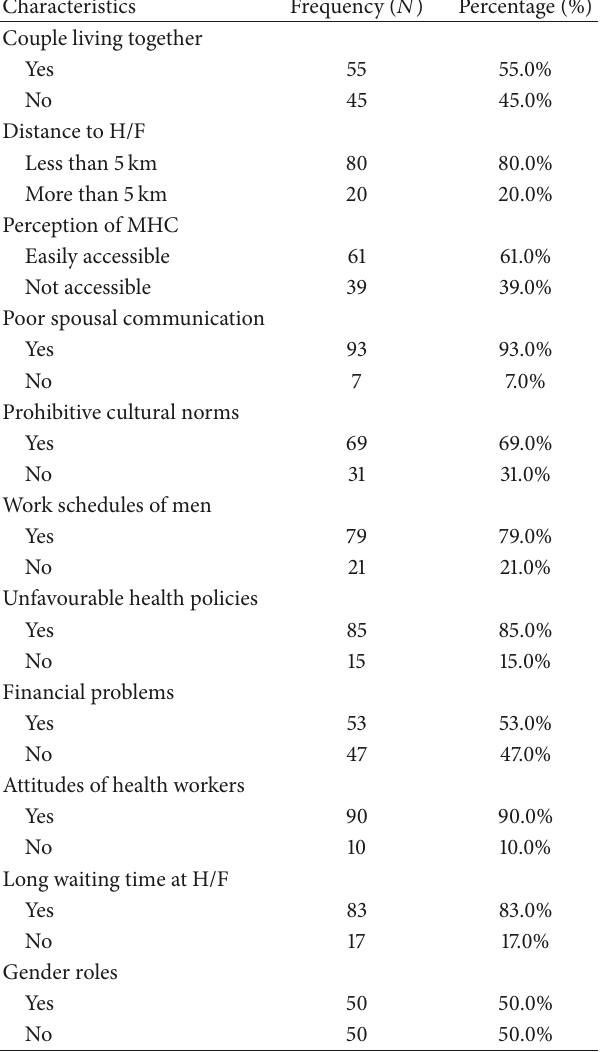
Table 2: Enabling/disenabling factors of male involvement in maternal health care ( N = 100).